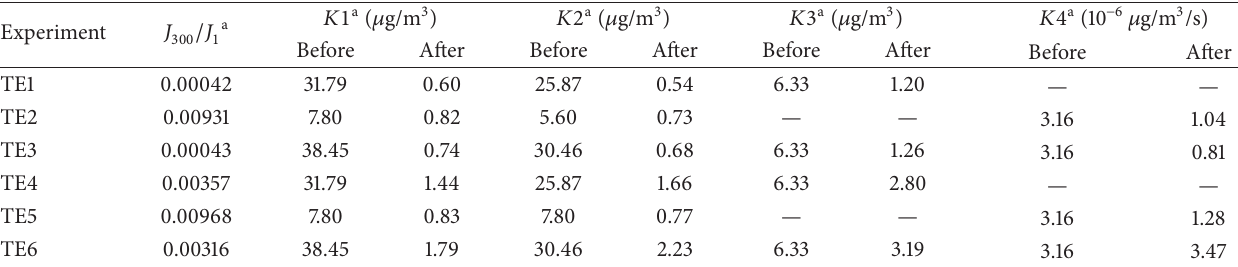
Table 2: Error statistics of twin experiments before and after assimilation.